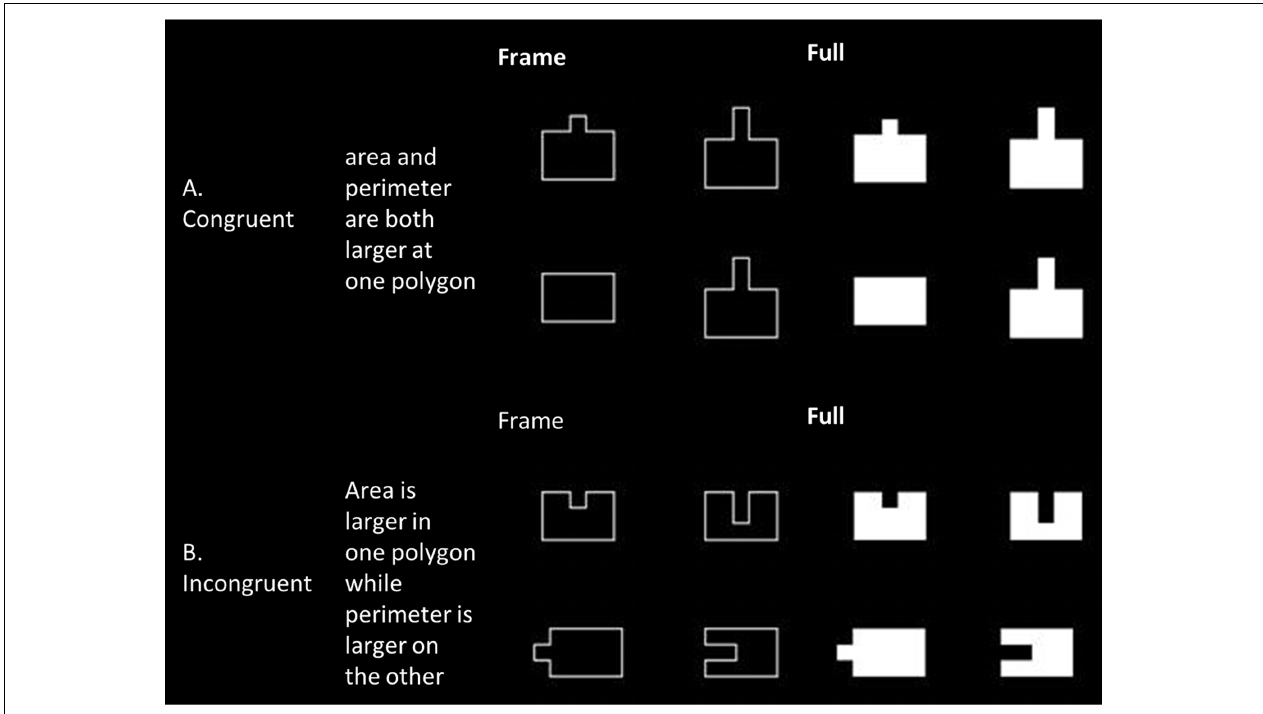
FIGURE 1 | Examples of framed and filled stimuli, arranged by congruency. (A) Examples of congruent stimuli, where both area and perimeter are increased in both polygons. (B) Examples of incongruent stimuli, where a different aspect is increased in each polygon.